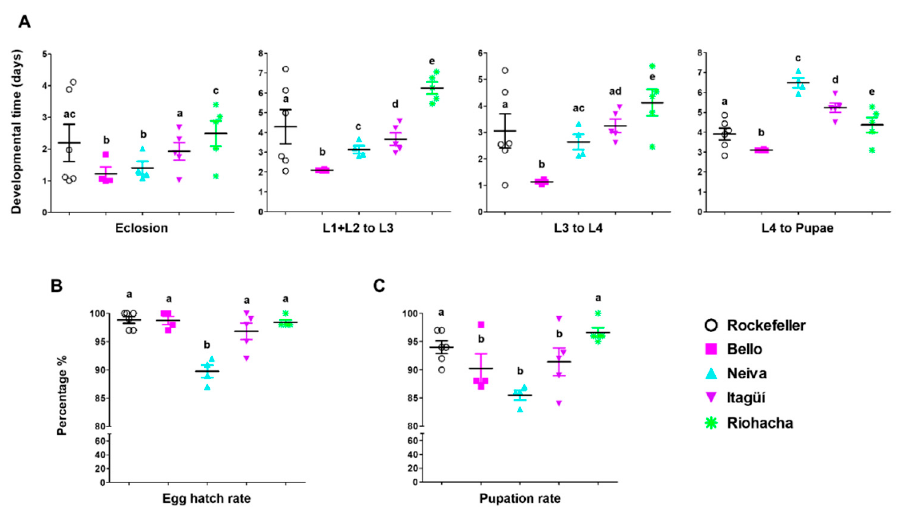
Figure 2. ( A ) Developmental time (days) of each immature instar, ( B ) egg hatch rate and ( C ) pupation rate of Colombian Ae. aegypti populations reared at 28 ± 1 °C temperature, 80 ± 5% relative humidity, and 12 h light: 12 h dark photoperiod. The mean and standard error of the mean were plotted. Each point represents a replicate from a cohort of 100 eggs. The total number of replicates were: Bello and Neiva (4); Itagüí and Riohacha (5), and control Rockefeller (6). L: larvae. The time to pupation is the mean development time from L4 to pupae. One-way analysis of variance (ANOVA) was conducted, followed by a Bonferroni post-hoc test to account for multiple comparisons between Ae. aegypti populations and the control (Rockefeller). Populations sharing the same letters are not significantly different ( p > 0.05).